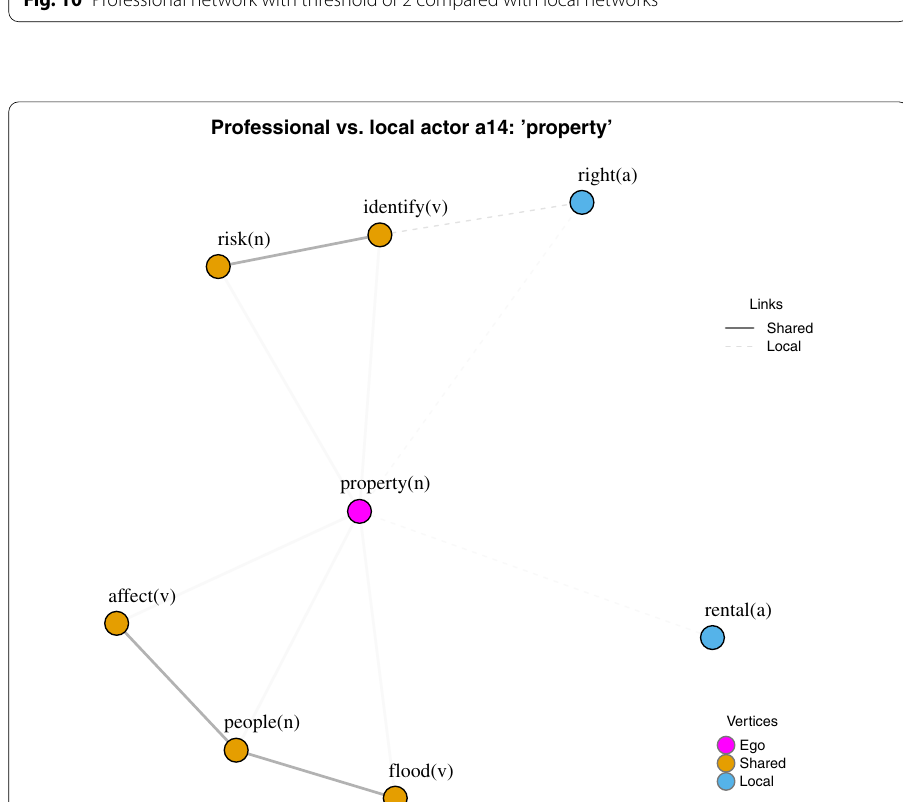
Fig. 11 The usage of the noun “property” in the professional and local actor a14 ’s